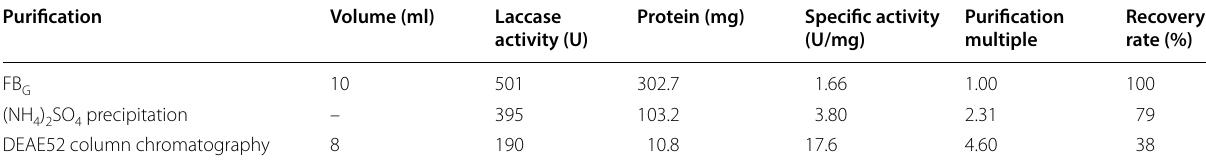
Table 2 Summary of laccase purification